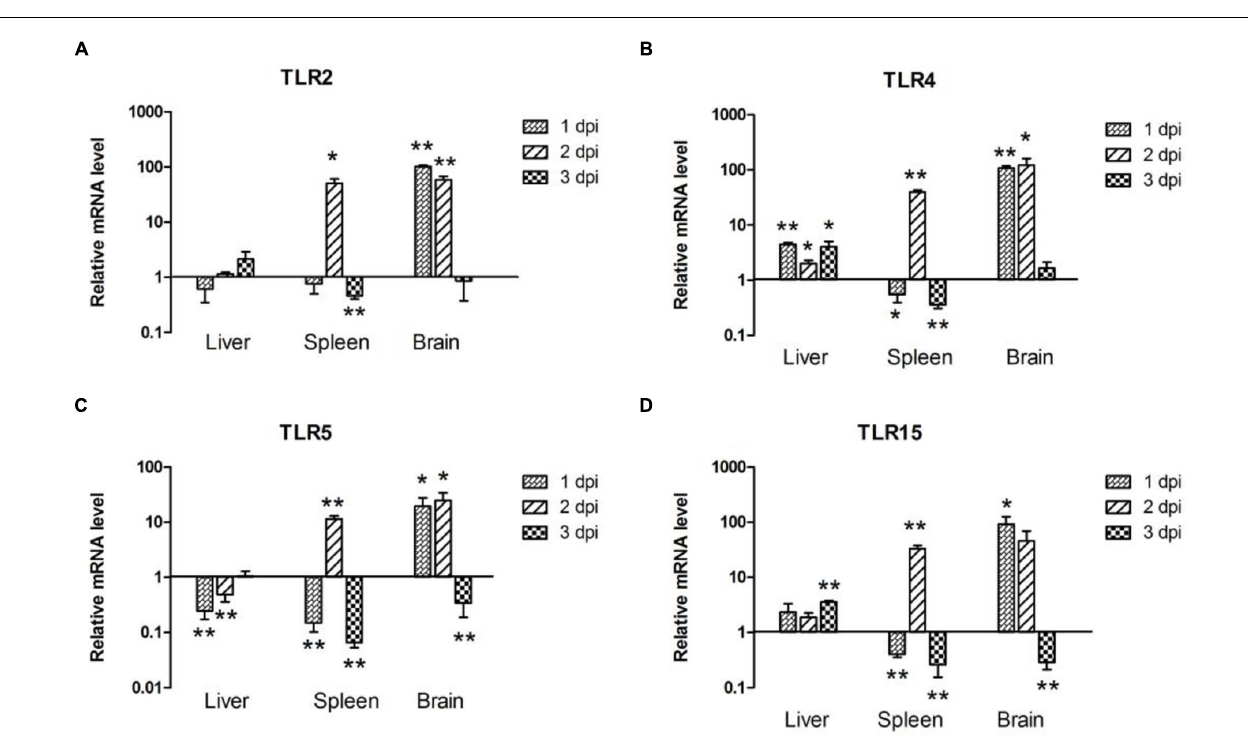
FIGURE 2 | The expression of toll-like receptors (TLRs) in the liver, spleen and brain from the APEC-infected ducks. (A) TLR2, (B) TLR4, (C) TLR5, (D) TLR15. Y -axis represents the fold change of target genes in the experiment groups versus those in control group. Data were expressed as means ± standard deviations ( n = 3). The difference was calculated by the Student’s t -test. ∗ P < 0.05, ∗∗ P <